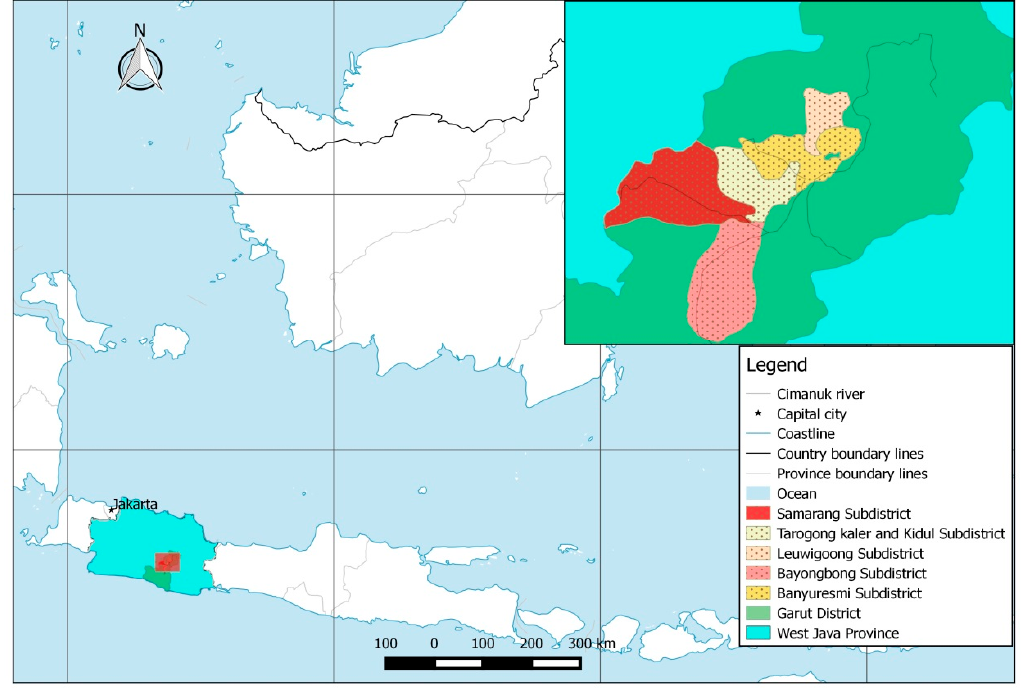
Figure 2. Location of the study district and the study’s six sub-districts.